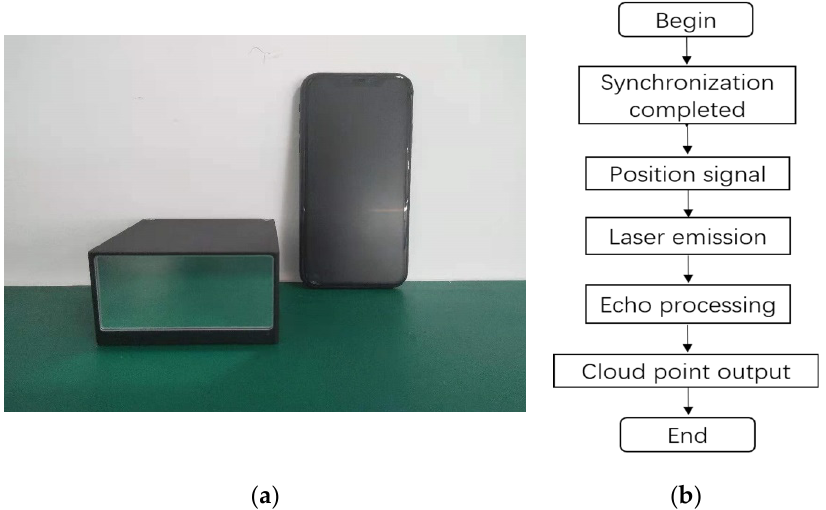
Figure 8. ( a ) Prototype of the MEMS LiDAR on the left and a smart phone (iPhone XR) on the right; ( b ) procedure of the MEMS LiDAR ranging process. ( b ) procedure of the MEMS LiDAR ranging